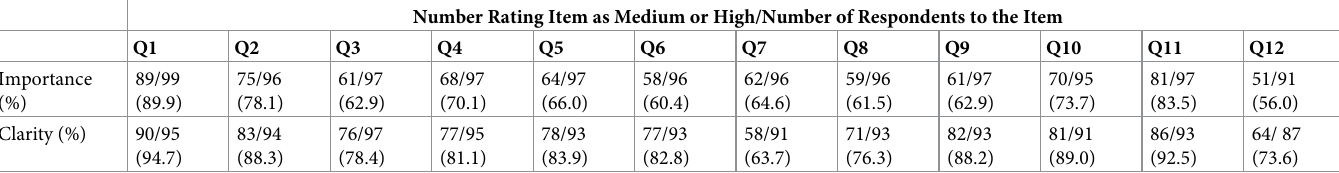
Table 4. Content validity utilizing patient evaluation of Item importance and clarity.